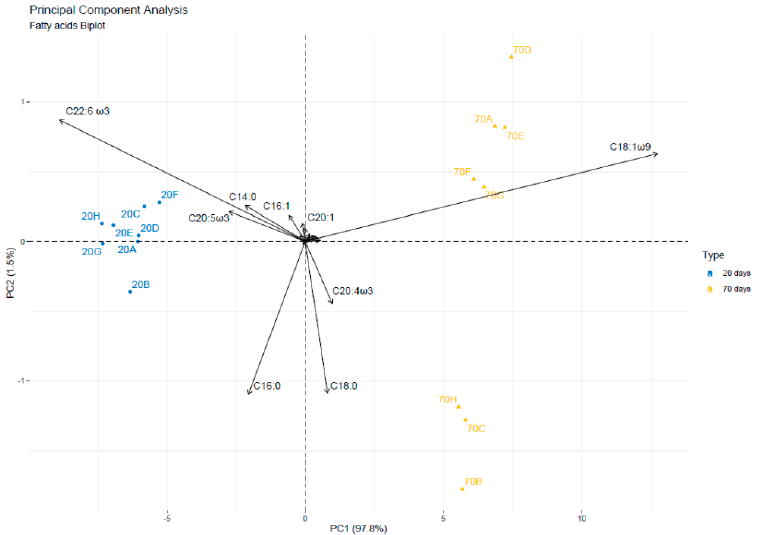
Figure 3. PC1 vs. PC2 biplot of FAs patterns of the stomach oil samples analyzed, according to the sampling period (day 20 vs. day 70).